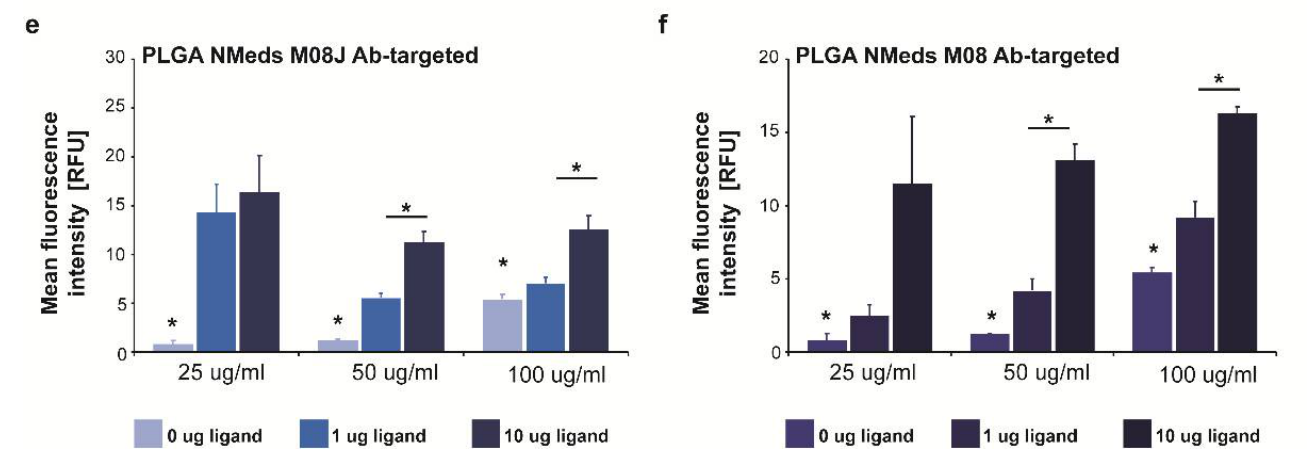
Figure 2. C6 cell uptake of 50 μg/mL targeted and non-targeted NMeds at ( a ) 3 h and ( b ) 24 h after administration. The relative fluorescence intensity of Cy5 intracellular signals (normalised to background fluorescence of untreated cells) was measured in 10 cells from n = 3 samples per condition. ( c – f ) Uptake of non-modified and targeted NMeds surfaced modified with 0, 1, or 10 μg of each ligand and administered at concentrations of 25, 50, or 100 μg/mL. The relative fluorescence intensity of Cy5 intracellular signals (normalised to background fluorescence of untreated cells) was measured in 10 cells from n = 3 samples per condition. Statistical analysis was performed with one-way ANOVA and post hoc test, * p < 0.5, ** p < 0.1, *** p < 0.01. Full statistical analysis is available in Supplementary material Table S5.